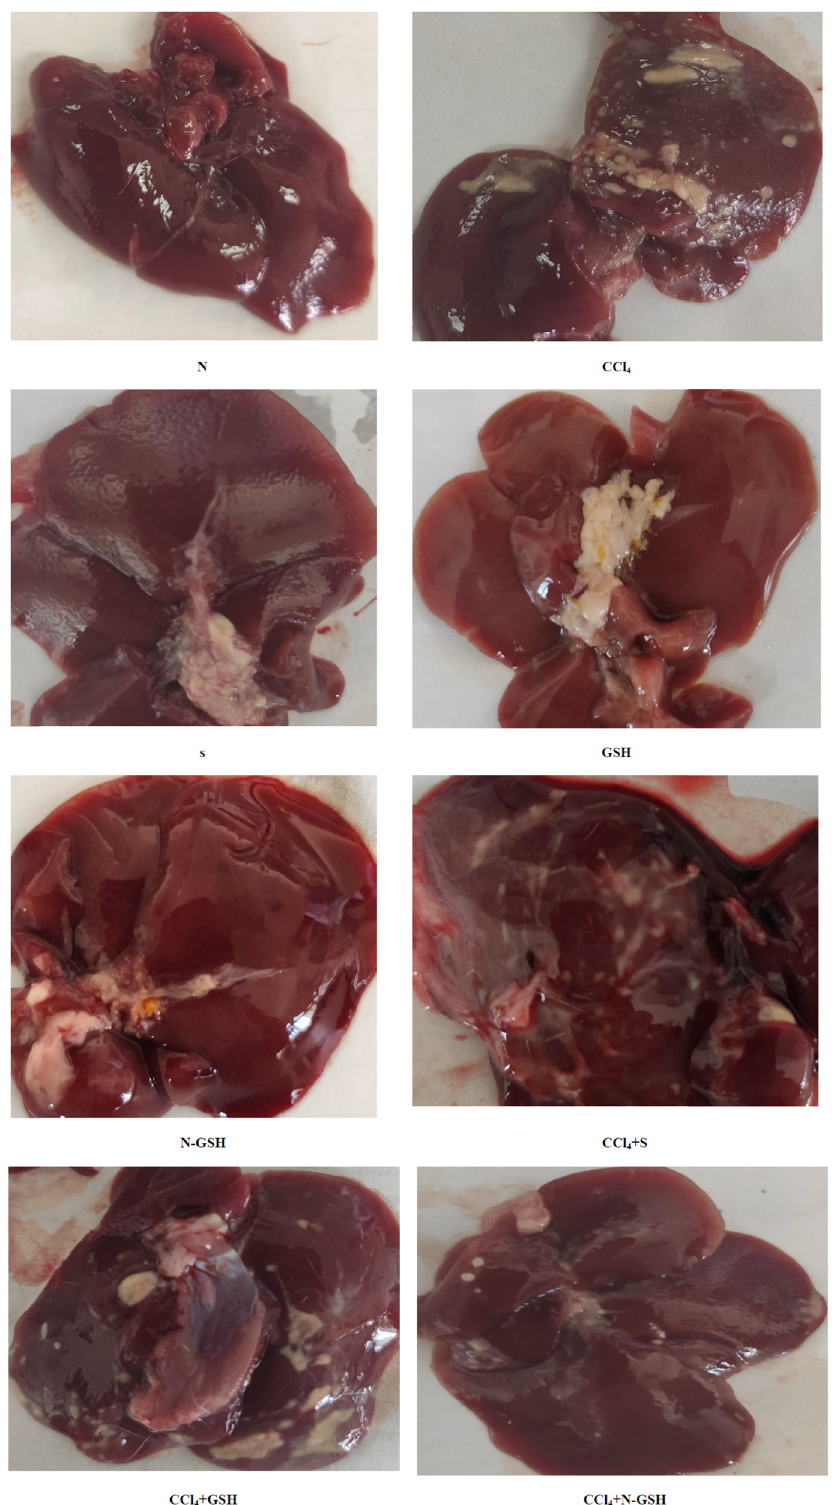
Figure 9: Macroscopic examination of the liver tissues from N, normal rats; CCl 4 , treated rats; S, silymarin - treated rats; GSH, glutathione - treated rats; N - GSH, nano - glutathione - treated rats; CCl 4 + S, CCl 4 + silymarin - treated rats; CCl 4 + GSH, CCl 4 + glutathione - treated rats; and CCl 4 + N - GSH, CCl 4 + nanoglutathione - treated